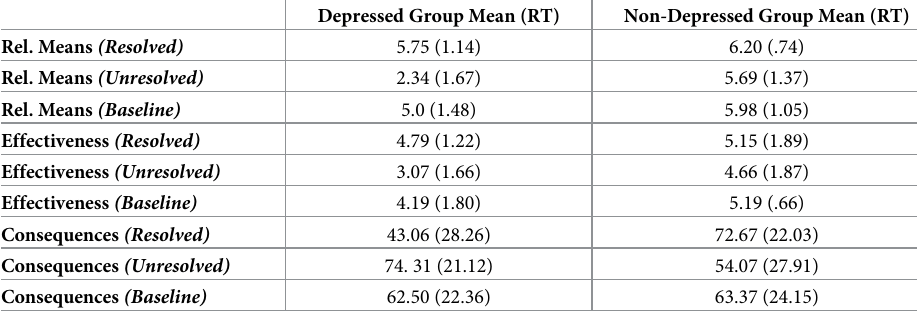
Table 2. Group differences in social problem-solving.